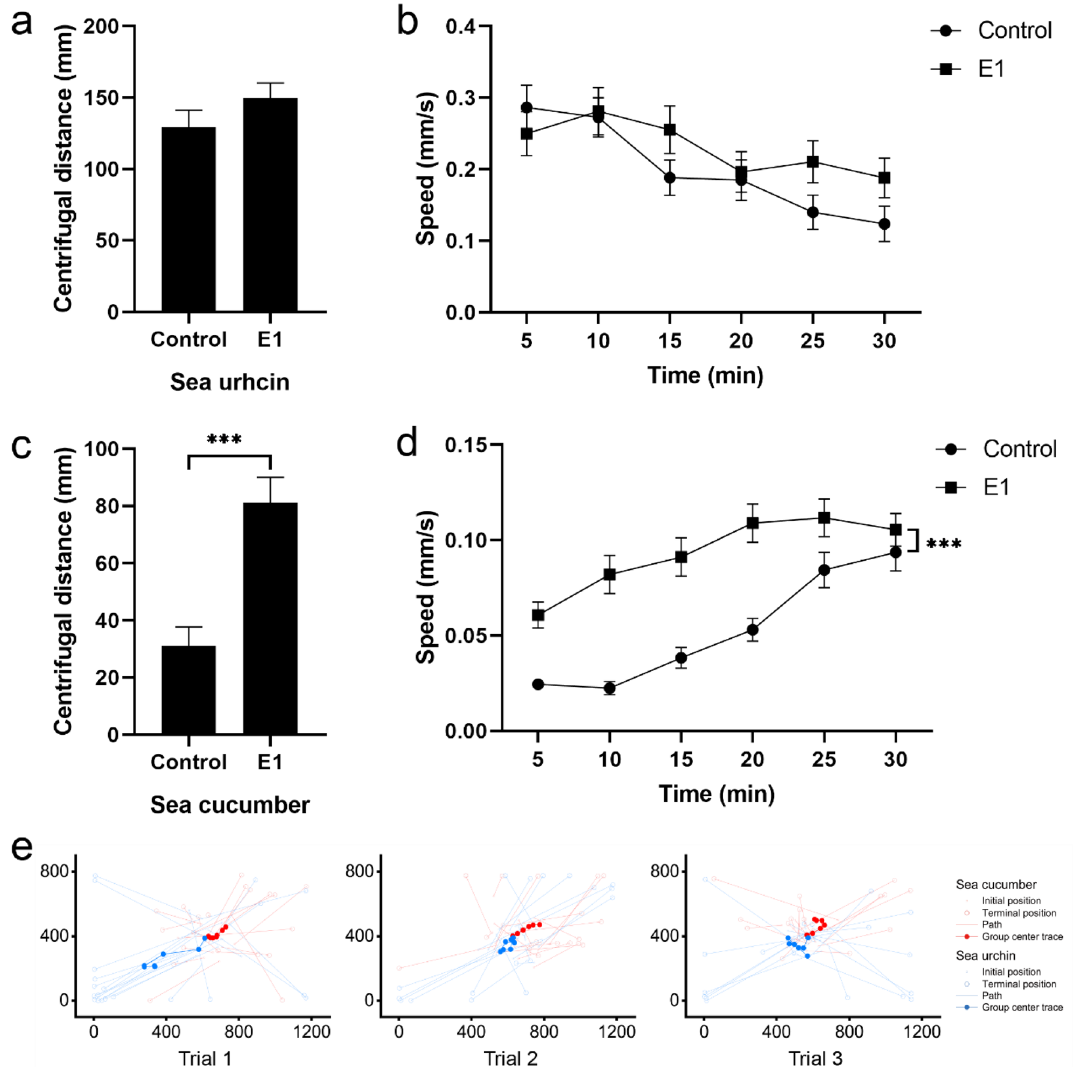
Figure 2. Behavioral interactions exist between sea urchins and sea cucumbers. ( a ) Average centrifugal distance and ( b ) movement speed (mean ± SEM) of sea urchins in the control group and group E1. ( c ) Average centrifugal distance and ( d ) movement speed (mean ± SEM) of sea cucumbers in control group and group E1. ( e ) The initial positions (small hollow point) and terminal positions (large hollow point) of sea cucumbers (light red) and sea urchins (light blue). Tracking of the center position (line through solid points) of the sea cucumber group (bright red) and the sea urchin group (bright blue) in all the three